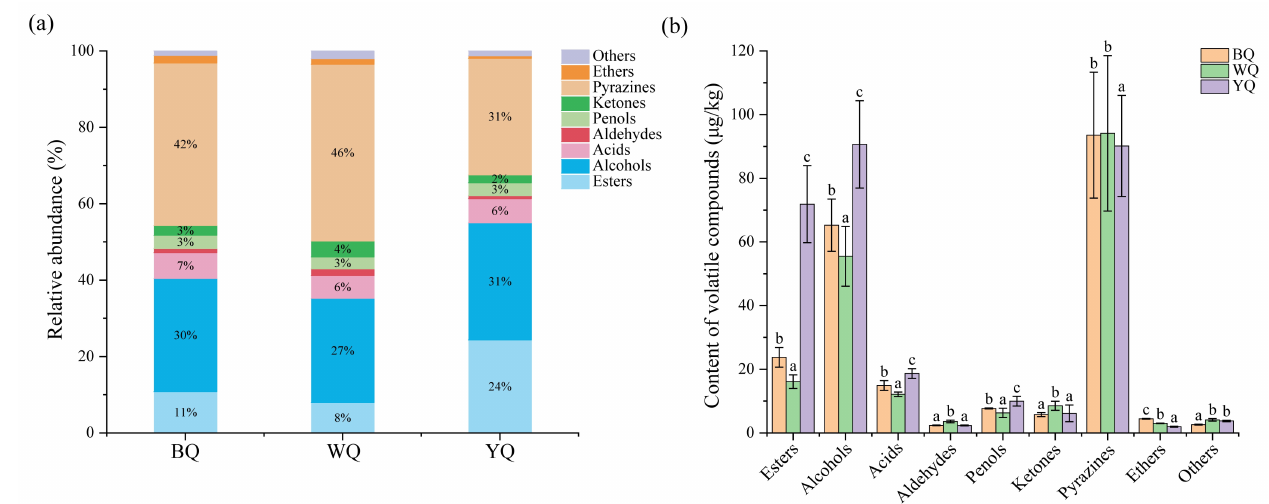
Figure 2. Different kinds of volatile compounds in three Daqu types. ( a ) Proportion of different volatile compounds. ( b ) Contents of various volatile compounds. The different letters represent the significant differences in the contents of volatile compounds between the samples ( p < 0.05).